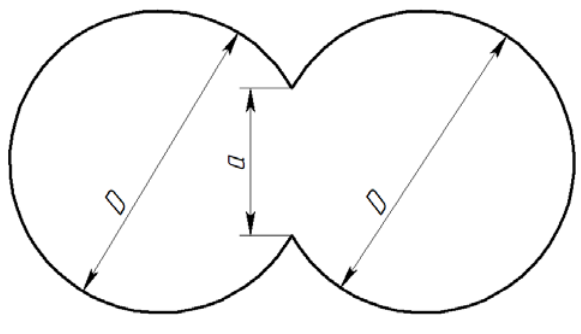
Fig. 2. Coalescence of two spherical particles of diameter D with formation of a neck of diameter